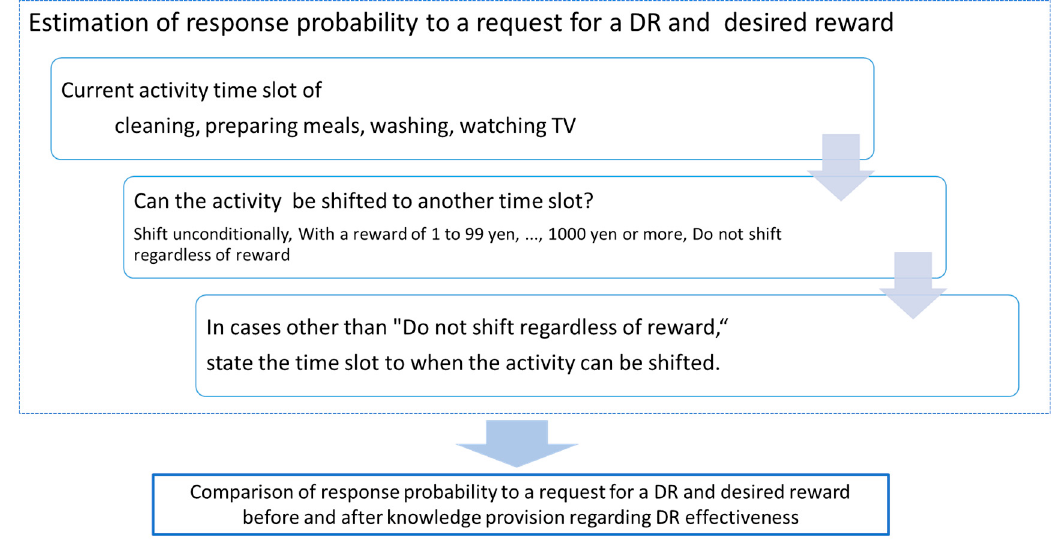
Figure 1. Flow of questions, where DR stands for demand response.